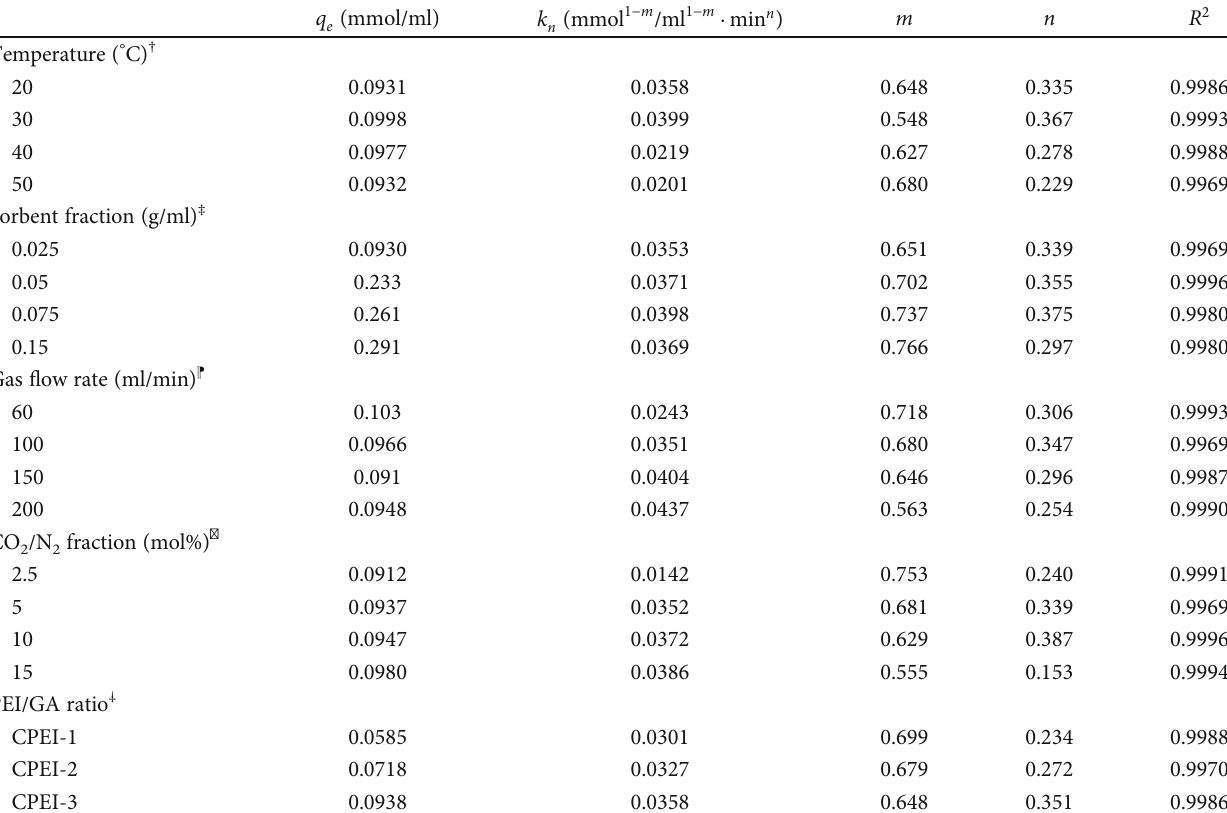
Table 2: Values of the kinetic model parameters.